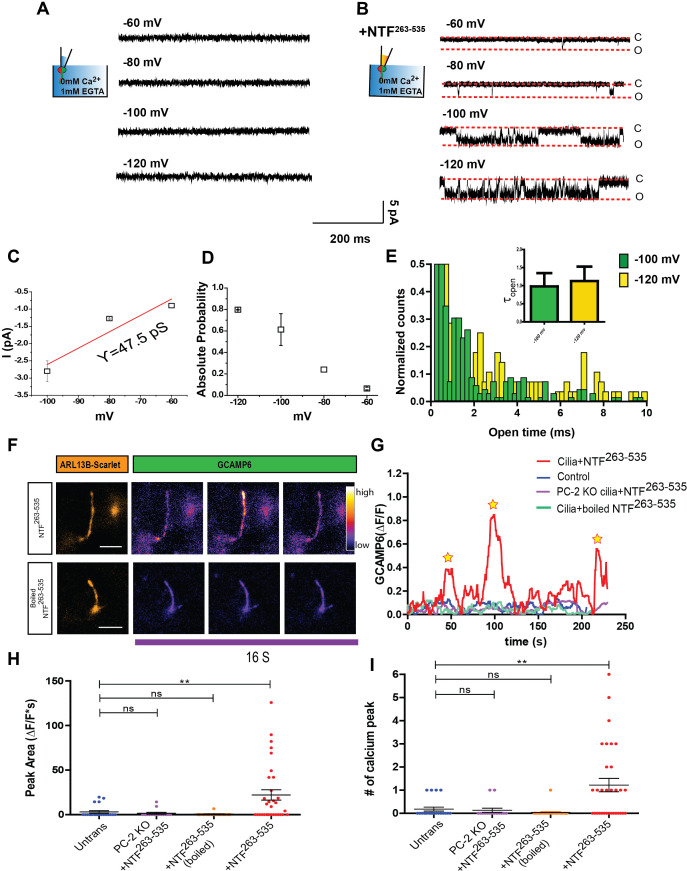
NTF263-535 activates Ca2+ influx into primary cilia.(A) Excised inside-out patch single channel recordings of mIMCD-3 cilia with 2 mM CaCl2 and 10 mM HEPES in pipette solution at membrane potentials between −60 mV and −120 mV. (B) Excised inside-out patch single channel recordings from mIMCD-3 cilia with 0.7 µg/mL of NTF263-535 in the pipette. Membrane potentials held between −60 mV and −120 mV. (C) I-V relationship obtained from ciliary excised patch clamp recordings from mIMCD-3 cilia with NTF263-535 (n = 3/16). Red line indicates linear fitting. (D) Absolute open probabilities obtained at membrane potentials between −60 mV and −120 mV (n = 3/16). (E) Open time histogram of channel opening events after NTF263-535 application at −100 and 120 mV. Small bar graph indicates time constants obtained from one decay fits of the histogram (n = 3/16). (F) Representative TIRF images after addition of 50 nM NTF263-535 to mIMCD-3 cells stably expressing Arl13B-scarlet-GCaMP6. GCaMP images are pseudo-colored based on pixel intensity. Scale bar: 5 µm. (G) Representative traces of changes in fluorescence (ΔF/F) during TIRFM imaging. Image acquisition every 250 ms. (H) Quantification of maximum peak area of fluorescence (ΔF/F*s) for control, PC-2 knock out cells + NTF263-535, wt mIMCD3 cilia + boiled NTF263-535, and wt mIMCD3 cilia + NTF263-535. (I) Quantification of number of calcium spikes observed in TIRFM imaging for control, PC-2 knock out cells + NTF263-535, wt mIMCD3 cilia + boiled NTF263-535, and wt mIMCD3 cilia + NTF263-535. Quantification is from three independent experiments, **p<0.01.